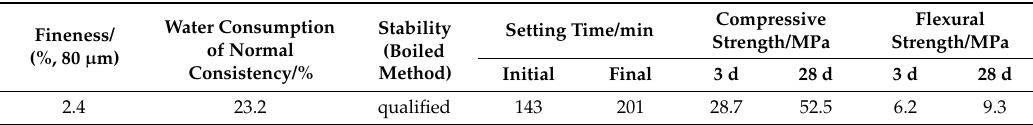
Table 2. Properties of ordinary Portland cement.